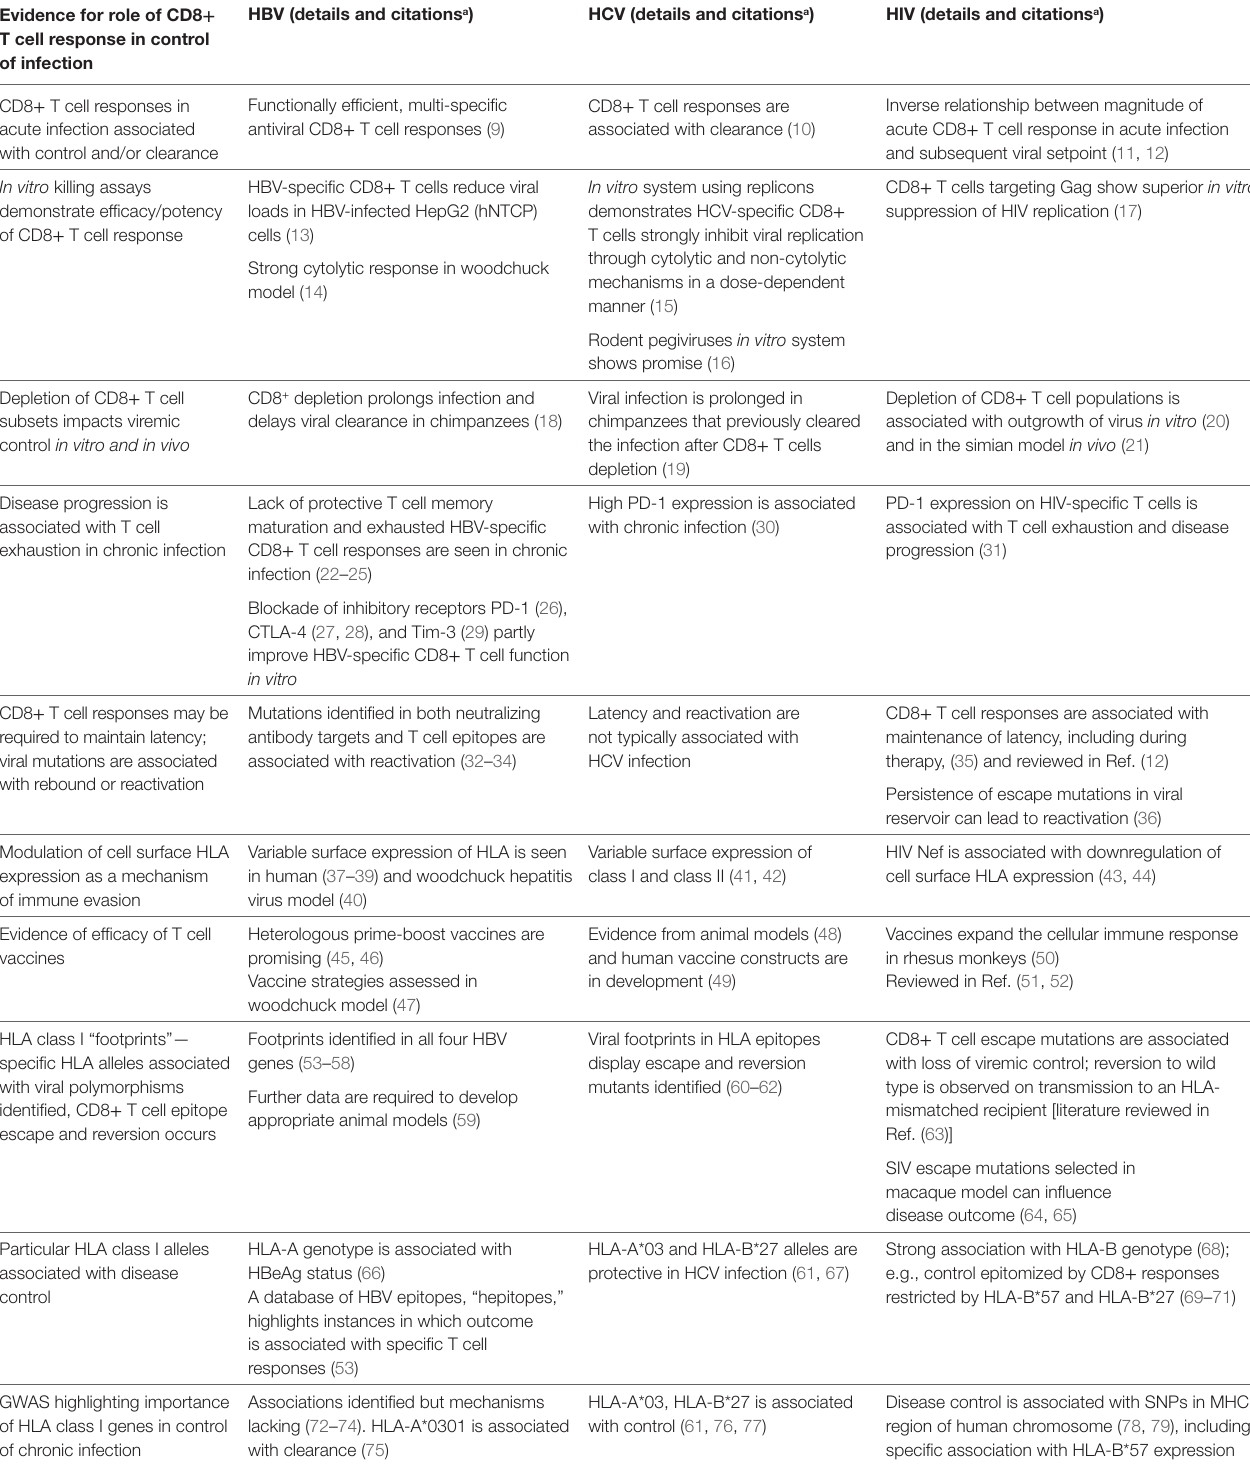
TABLe 1 | Strands of evidence for the significance of the CD8 + T cell response in control/clearance of infection with blood-borne viruses. evidence for role of CD8 + T cell response in